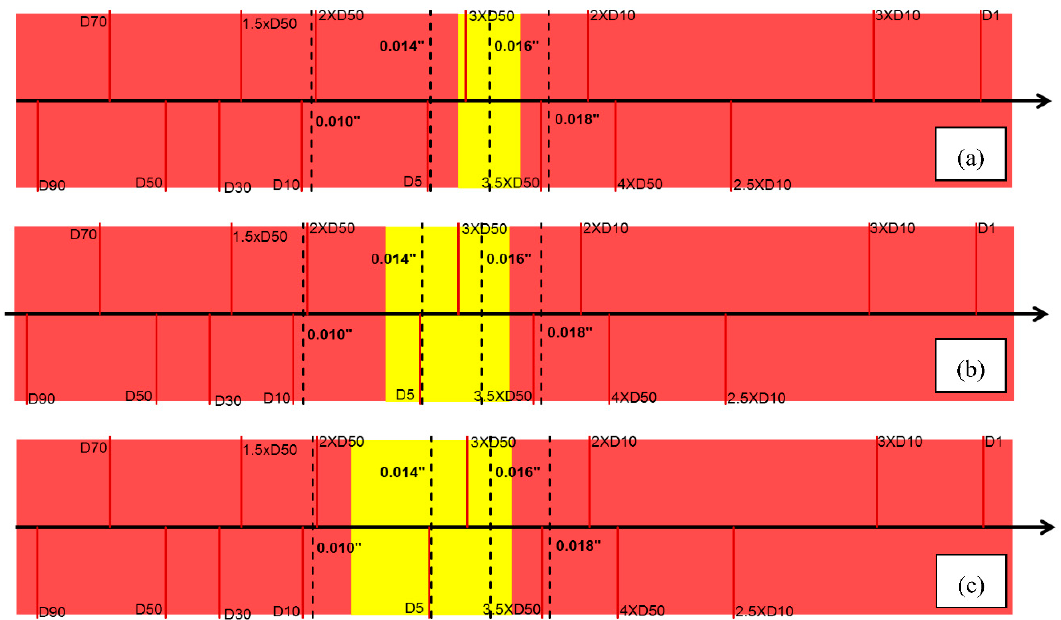
Figure 11. Tra ffi c light system (TLS) of DC-I in the normal condition for SPF 120 ( a ), SPF 168 ( b ), and Figure 11. Traffic light system (TLS) of DC ‐ I in the normal condition for SPF 120 ( a ), SPF 168 ( b ), and SPF 216 ( c ). Energies 2020 , 13 , x FOR PEER REVIEW 11 of 18 SPF 216 ( c ).